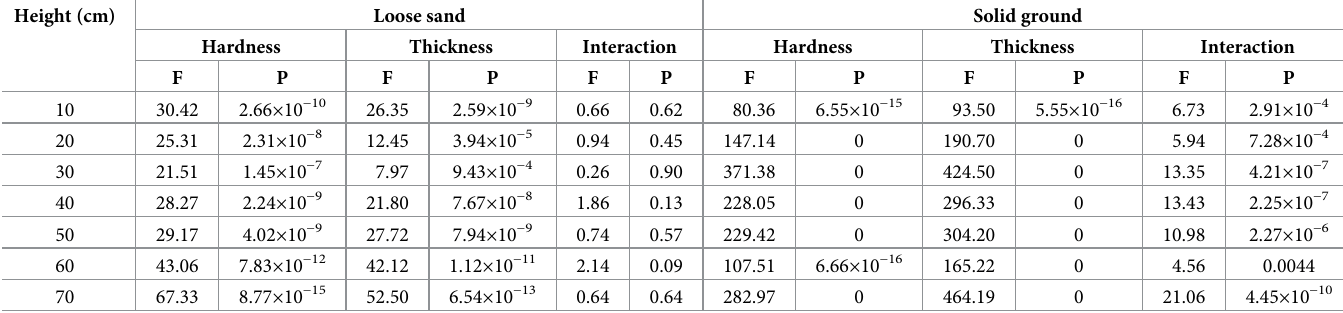
When the thickness is 45 mm and the hardness is 55 HA (Fig 8E), the fluctuations of peak accelerations of cushioning foot are enlarged with the increasing impact height. It also indi- cates that with the thicker and harder silicone rubber, the peak acceleration of the cushioning foot will fluctuate more severely, and the cushioning performance will be greatly affected. Therefore, we further performed significance analyses of both hardness and thickness. Significance analyses of both hardness and thickness Significance analyses show both hardness and thickness are two significant influence factors on the cushioning performance, irrespective of loose sand or solid ground (Table 5). However, the effect of hardness is more significant than that of thickness on loose sand, because the P values of hardness are all smaller than those of thickness at different heights. Cushioning performance of the bio-inspired foot with spring The 15-35-55 HA bio-inspired foot with spring shows less peak accelerations and thereby bet- ter cushioning performance than the 15-15-15 HA bio-inspired foot, irrespective of loose sand or solid ground (Fig 9).